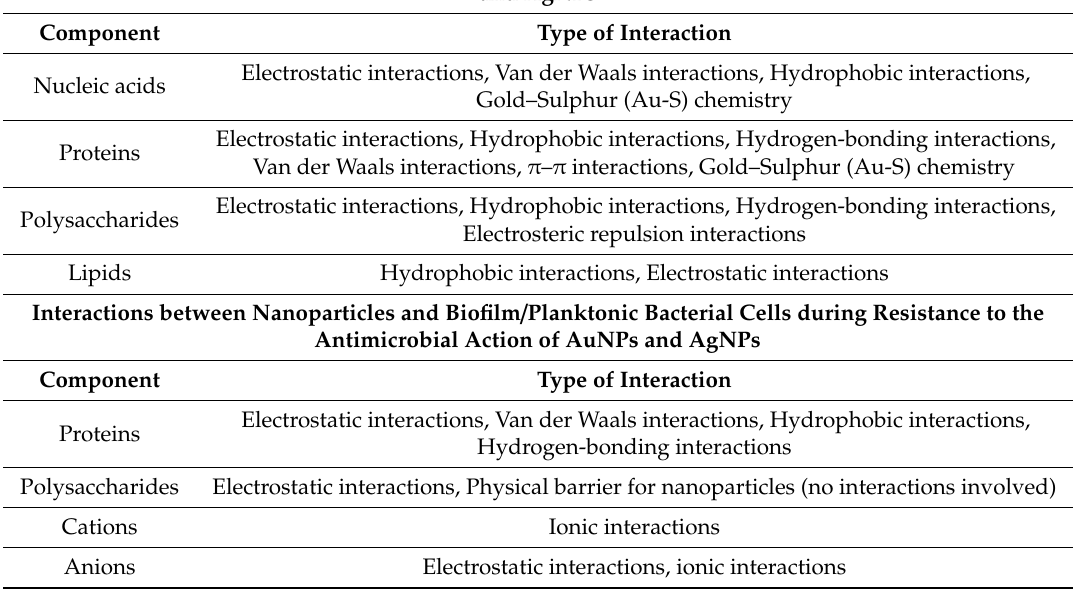
Table 1. Summary of interactions between biofilm components and gold / silver